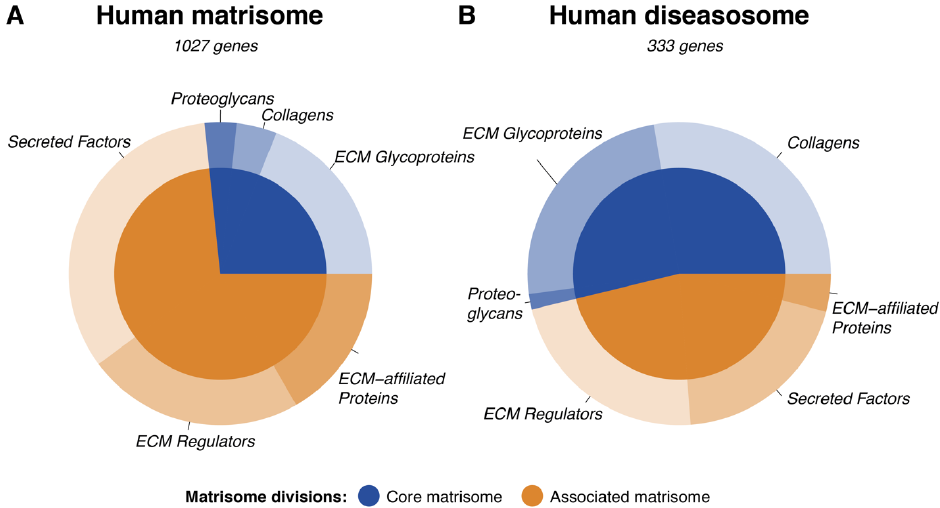
Figure 4. Involvement of the Human Matrisome in Pathology. The composition of the human matrisome is illustrated using a circular diagram reflecting the relative abundances of the core (blue) and associated (brown) matrisome divisions in the overall matrisome ( A ) and in the part of the matrisome which is specific to disease (( B ), Supplementary Table S8). The divisions are further subdivided by the matrisome categories they contain. The subset of the human matrisome (1027 genes) responsible for the diseases (333 genes) is approximately 30% of the total and is enriched with collagens. This overrepresentation of collagens further highlights the importance of collagenopathies.